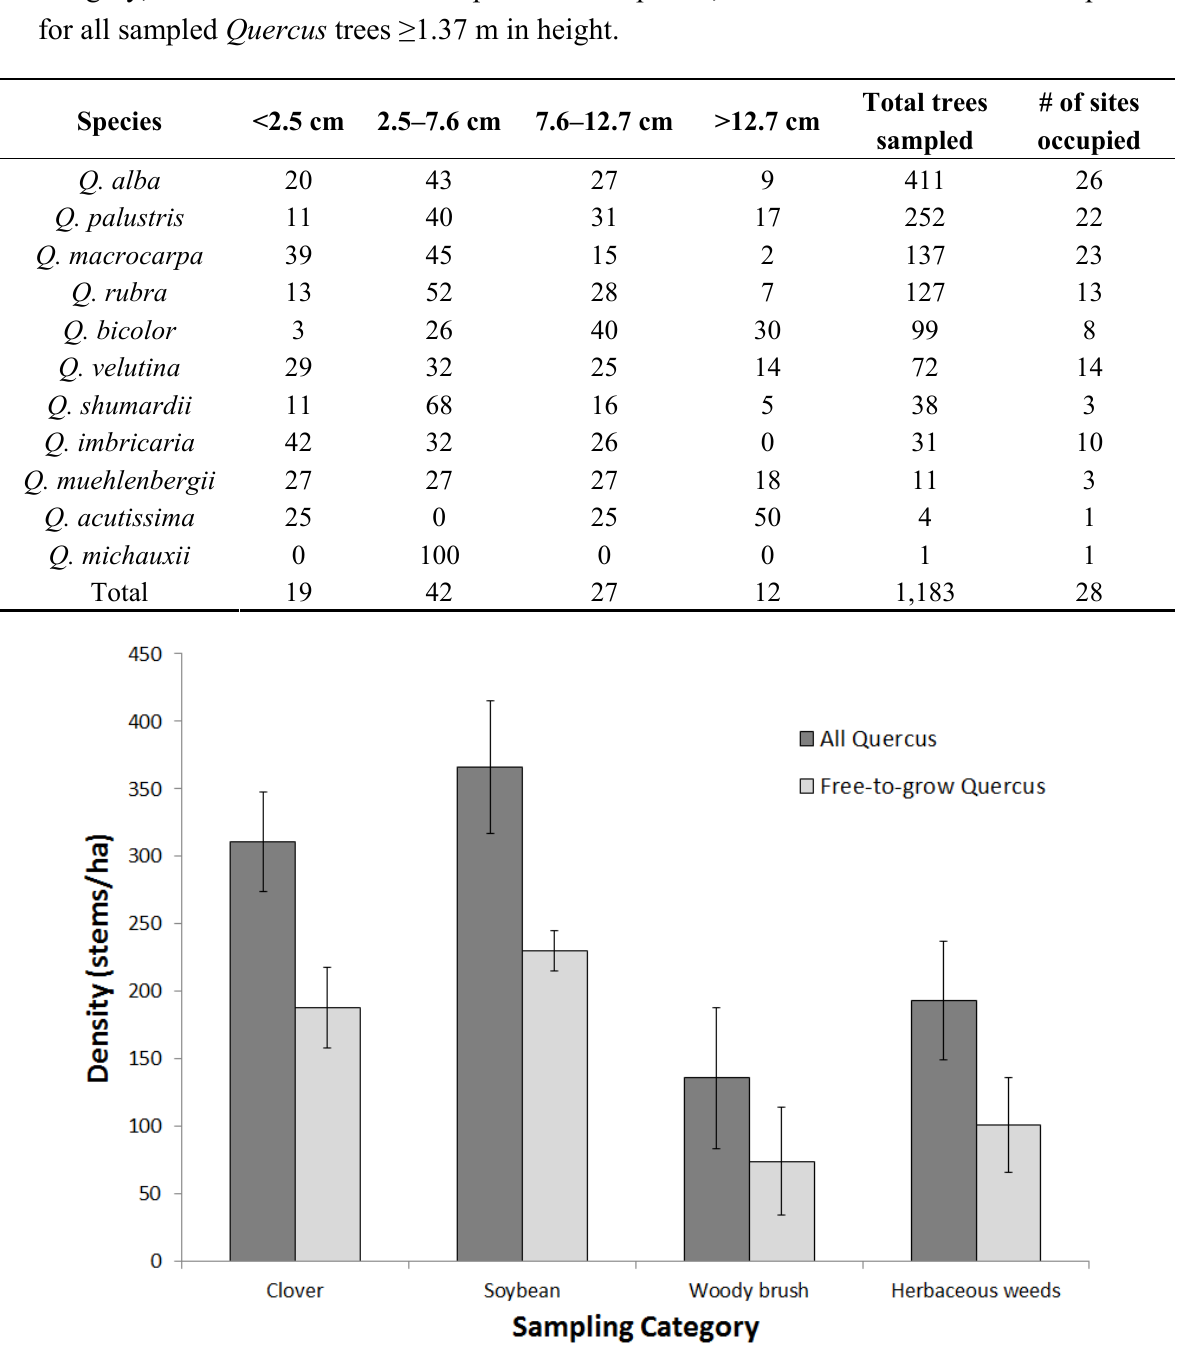
Figure 1. Density (stems/ha ± S.E.) of all Quercus stems and free-to-grow Quercus stems by Land Cover Type (LCT). Across LCT, there was a significant difference in total Quercus density and free-to-grow Quercus density , F = 4.86, p = 0.01 and F = 3.71, p = 0.03,